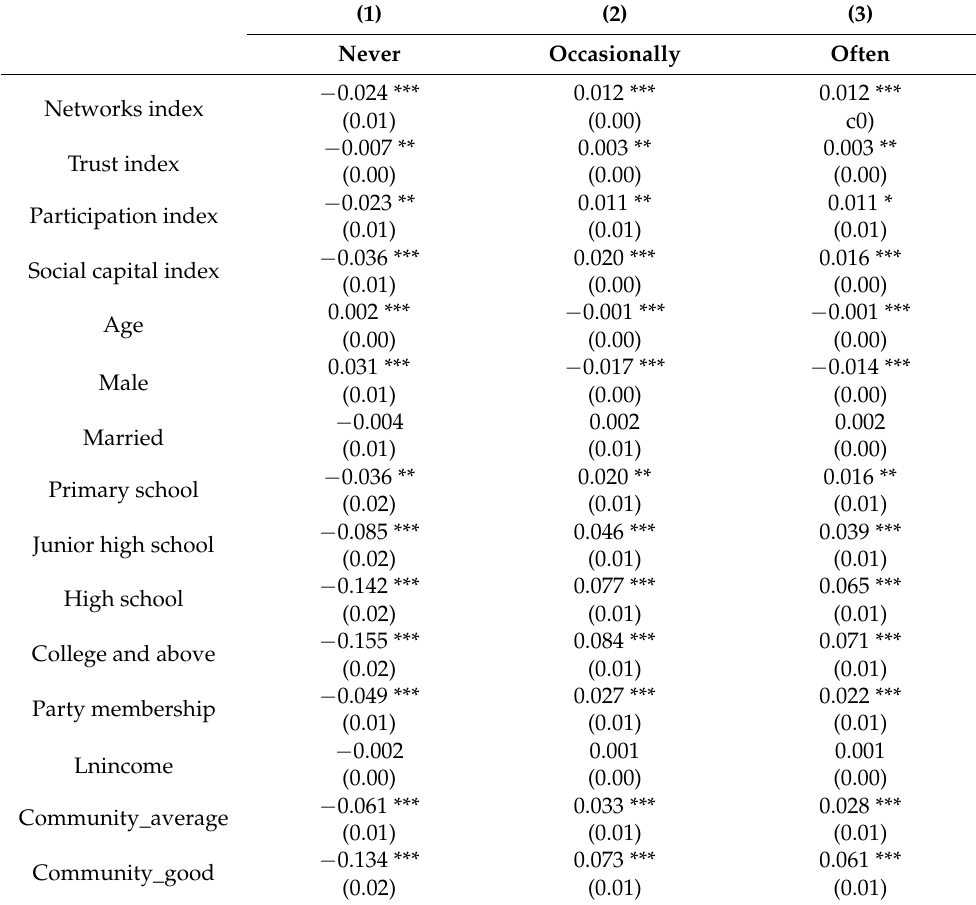
Note: The marginal effects reported in Table 4 are based on the regression results in column (4) of Table 3, basically consistent with the marginal effects using social networks, social trust, and social participation as explanatory variables. The marginal effect results based on columns (1), (2) and (3) of Table 3 are presented in Appendix B. The values in parentheses indicate the standard error of town/sub-district level clustering. clustered